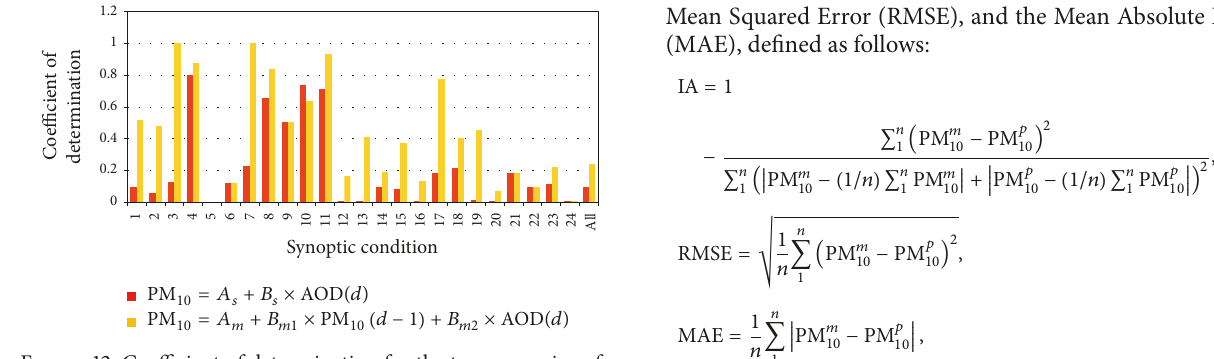
Figure 12: Coefficient of determination for the two regressions for theAyiaMarinastationintermsoftheprevailingsynopticcondition (1–24) and for all cases irrespective of the synoptic condition (shown as All).